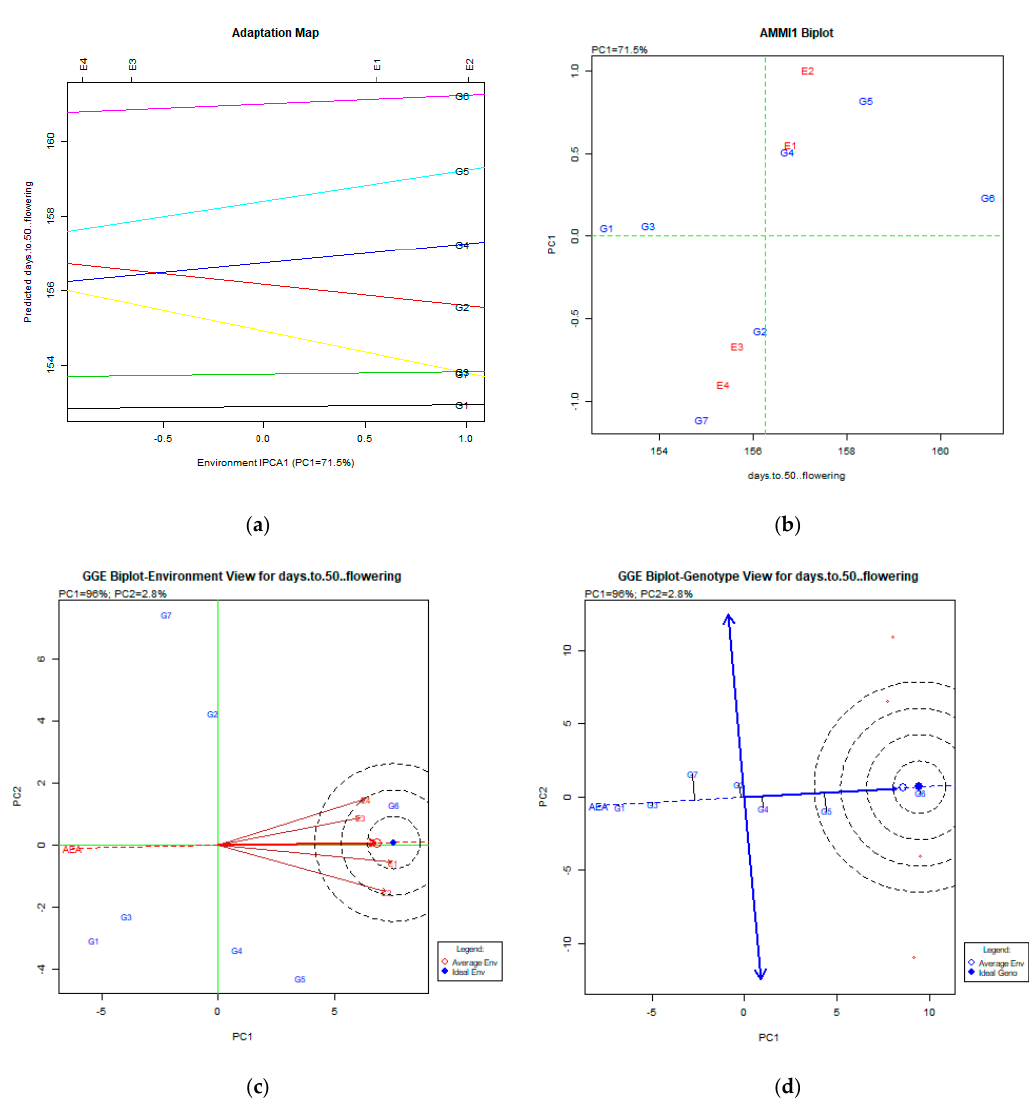
Figure 1. Stability analysis for days to 50% flowering based on ( a ) adaptation map, where the environmental stability of the genotypes is visualized by the X − axis (PC1) and the performance of the trait for the genotypes is tested by the Y − axis; ( b ) AMMI1 biplot, where the environmental stability of the genotypes is visualized by the X − axis (PC1) and the performance of the trait for the genotypes is tested by the Y − axis; ( c ) GGE biplot depicting the environmental stability over time for the desirable genotypes placed near to the ideal environment; ( d ) GGE biplot for genotypes depicting the genotypic stability in different environments. The desirable genotypes are those placed near the concentric region of the ideal genotype.